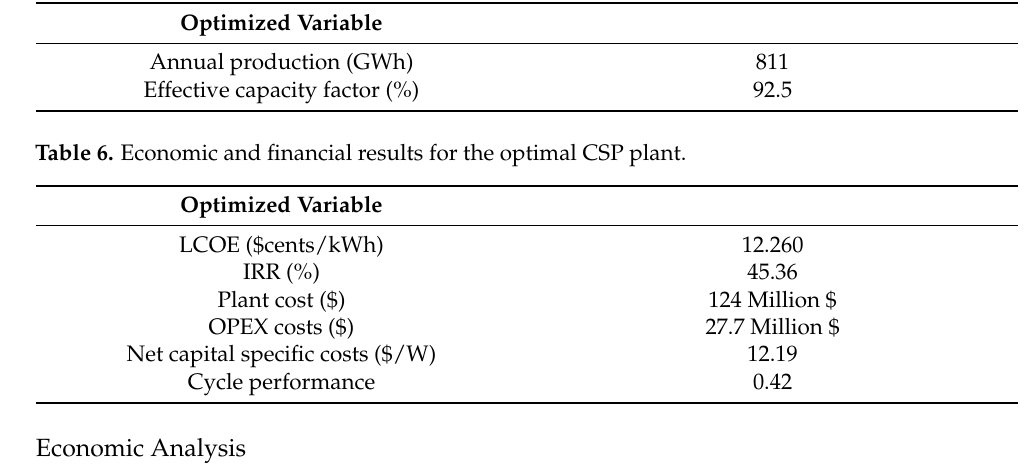
Table 5. Production results for the optimal CSP design.